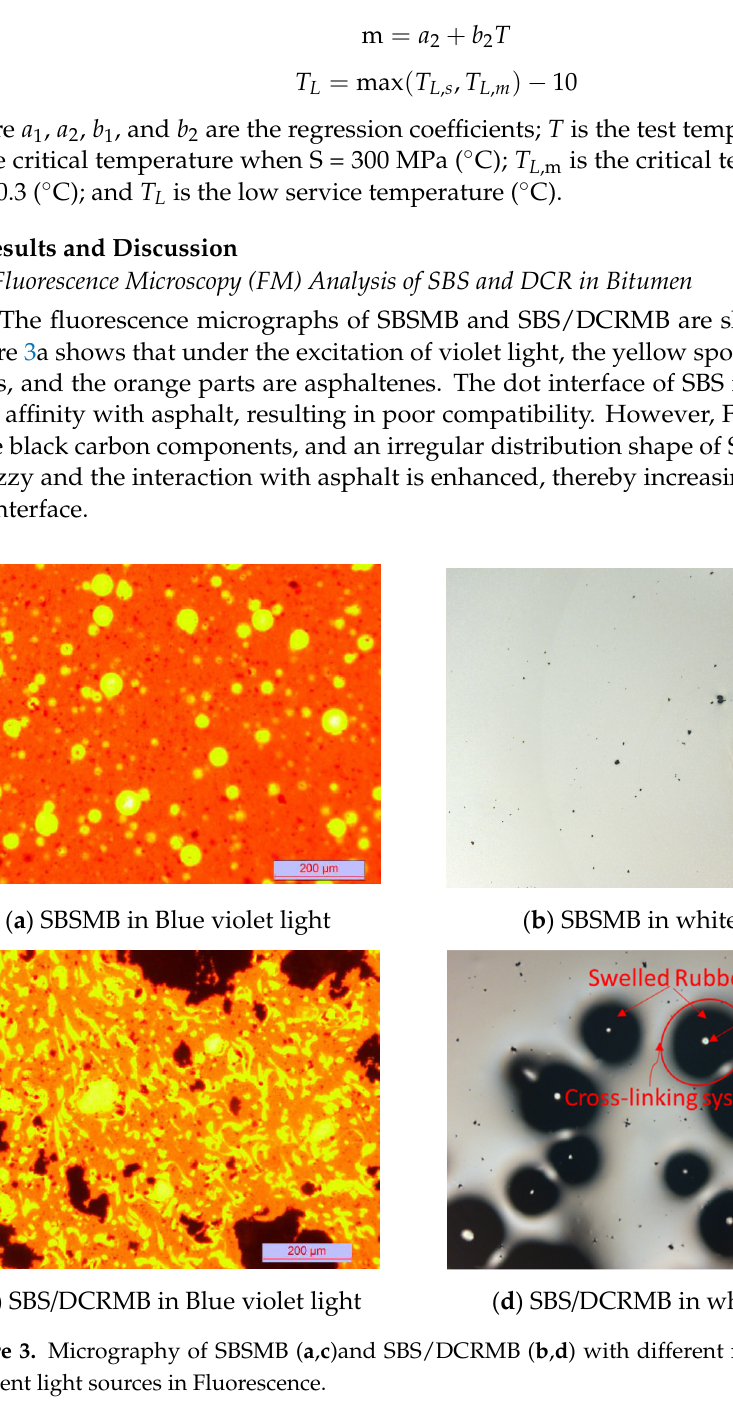
Figure 4. Modification mechanism of SBS/DCRMB. 3.2. Molecular Distribution Analysis with GPC GPC analysis can effectively characterize the molecular structure and the decompo- sition of polymers during the aging process [42]. According to Figure 4, two regions can be observed from the GPC chromatogram of SBS/DCRMB and SBSMB. These are the re- sidual matrix bitumen region on the left (with smaller molecular weight) and the polymer region on the right (with larger molecular weight). The appearance of the two molecular weight regions in SBS/DCRMB indicates that a mixed crosslinking system formed be- tween SBS and DCR. The existence of a crosslinking system is verified via fluorescence microscopic images under white light. Focusing on the left region, Figure 5a shows that the aging effect leads to significant differences among the three peaks of the molecular weight distribution of residual as- phalt. In contrast, the SBS/DCRMB residual bitumen molecular weight distribution curve shown in Figure 5b approximates an overlap and with good consistency. This may be ascribed to the following two reasons: On the one hand, the aromatics component is ab- sorbed by the swelling of polymer components during the preparation of SBS/DCRMB.